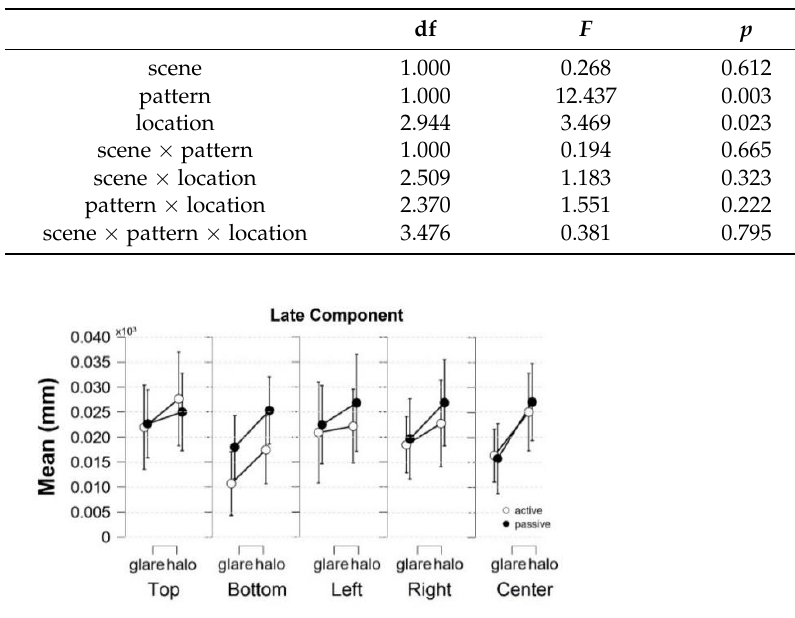
Figure 5. Descriptive plots of Bayesian rmANOVA in the late component. The mean of pupil diameter change (mm) in response to the stimuli at the bottom was the smallest value compared with the other locations in the world-centered coordinates. Error bars indicate lower and upper values with a 95% credible interval.